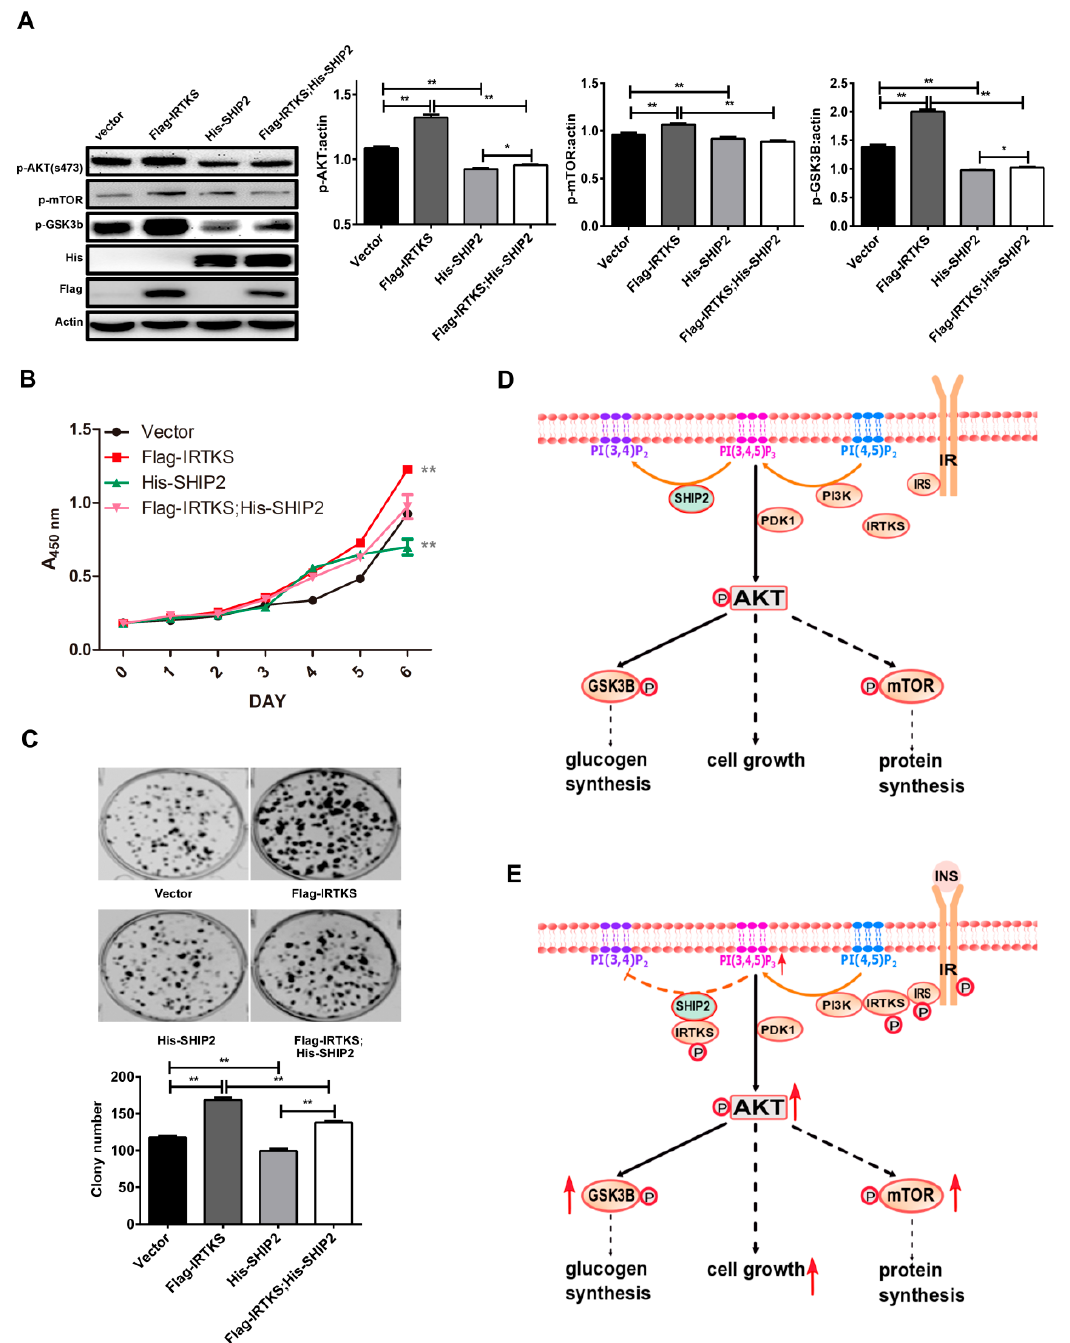
Figure 5. IRTKS promotes insulin signal transduction and cell proliferation partially due to inhibiting SHIP2 activity. ( A ) SK-Hep-1 cells transfected with Flag–IRTKS and/or His–SHIP2 were stimulated with insulin for 15 min. The phospho-AKT(S473) (p-AKT), phospho-mammalian target of rapamycin (S2448) (p-mTOR), and phospho-glycogen synthase kinase-3 beta (S9) (p-GSK3 β ) were detected by Western blotting assay and were quantitated with three replicates. The data are shown as mean ± SD. * p < 0.05, ** p < 0.01 (Student’s t -test). ( B ) The proliferation curve of SK-Hep-1 cells overexpressing Flag–IRTKS or His–SHIP2 was monitored by cell counting kit-8 (CCK8) at the indicated times. ( C ) Colony formation of SK–Hep-1 cells overexpressing Flag–IRTKS or His–SHIP2 was determined by Coomassie blue. ( D , E ) Schematic diagrams of molecular mechanism involved in the IRTKS enhanced insulin signaling transduction through inhibiting SHIP2 enzyme activity. As known, insulin signaling transduction could promote cell proliferation [11]. With insulin stimulation, IRTKS is phosphorylated by IR and then enhances PI3K activity, increasing the